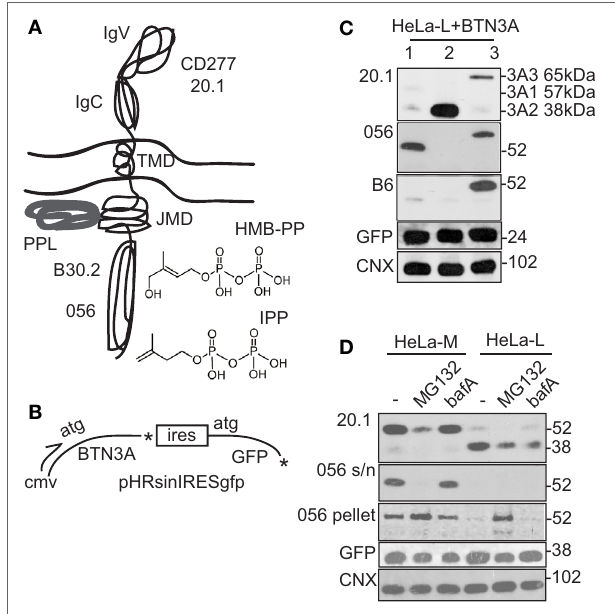
FigUre 3 | Detection of BTN3A1 by re-expression in shRNA BTN3A cells. (a) Diagram of BTN3A1 protein and structure of the two principal stimulatory phosphoantigens (pAg) hydroxy-3-methyl-but-2-enyl pyrophosphate (HMB-PP) and isopentenyl pyrophosphate (IPP). Sites of pAg interaction in the BTN3A1 B30.2 domain, protein periplakin (PPL) interaction at the juxta-membrane domain (JMD) and the antibodies used for detection are highlighted. BTN3A3 has a structure similar to BTN3A1, whereas BTN3A2 is truncated after the JMD and lacks the B30.2 domain. (B) Diagram of BTN3A pHRsinIRESgfp lentiviral expression vector used in re-expression studies. Independent measure of transgene expression is provided by internal ribosome entry site (IRES) driven green fluorescent protein (GFP). (c) Western blot of HeLa-L cells transiently transfected with expression vectors for BTN3A1, BTN3A2, and BTN3A3. Monoclonal anti-BTN3A (CD277 20.1) antibody and polyclonal sera 056 and B6, directed to B30.2 domains of BTN3A1 and BTN3A3, respectively, were used. Anti-GFP and calnexin (CNX) antibodies provided loading controls for expression of transgene and endogenous proteins, respectively. (D) Western blot analysis of stable BTN3A1 re-expression lines of HeLa-L and HeLa-M shRNA BTN3A cells, either left untreated or treated with MG132 or bafilomycin A (bafA). Anti-CD277 20.1 antibody and polyclonal sera 056 were used, together with anti-GFP and CNX control antibodies as in (c) . Detection of CD277 20.1 and 056 reactive protein bands required extended exposure to X-ray